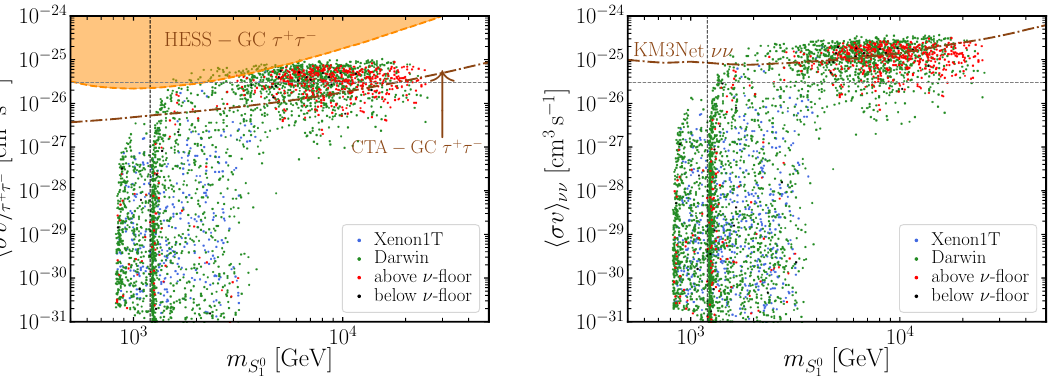
Figure 7 . Dark matter perturbative velocity-averaged annihilation cross section into τ + τ − and νν . On the left, limits from HESS [63] are represented by a dashed orange line. The CTA sensitivity estimate of [64], assuming 500h of observation towards the galactic center, is depicted in dash-dotted line. On the right, sensitivity prospects for KM3Net [54, 55] are shown in dash-dotted line. The color code is the same as in figure 5, as described in section